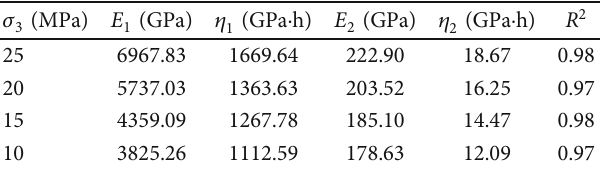
Figure 8: Creep curve of NVPB model.